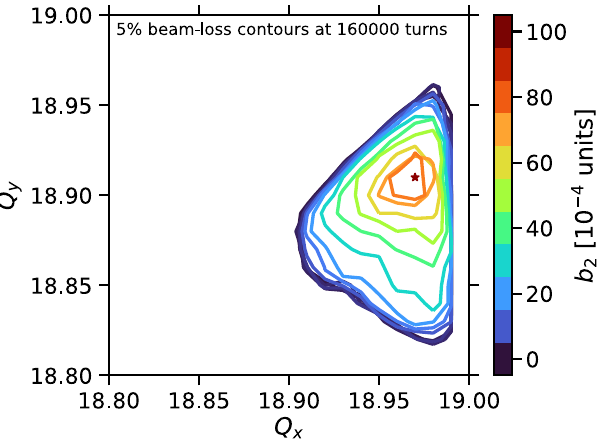
FIG. 13. Low-loss area contours for the cold symmetric lattice, the broken-symmetry lattice with the two warm quadrupole magnets, and the latter plus two corrector magnets. The full injection plateau is simulated with the magnet field error model and the FFSC model.